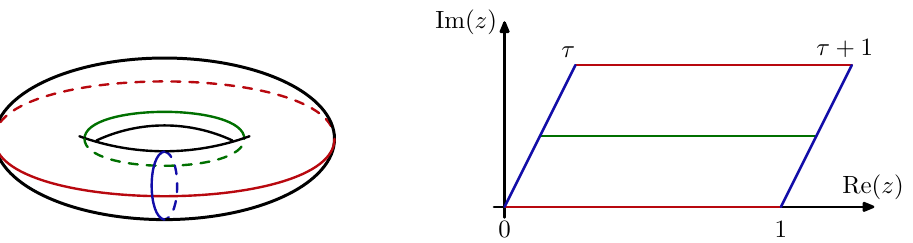
Figure 1 . Torus with A - and B -cycle (red and blue) and their images as boundaries of the fundamental domain. The green line marks the additional cut necessary to obtain the cylinder and M(cid:27)bius-strip worldsheets for the open string as the parallelogram below if (cid:28) 2 i R and (cid:28) 2 i R + 1